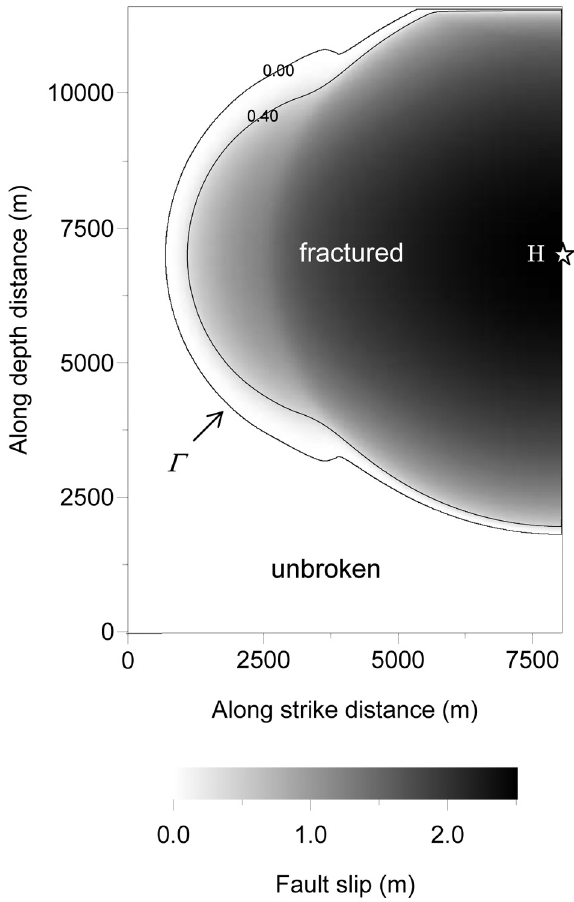
Figure 1. Distribution of the fault slip developed by a 3–D synthetic earthquake at time t = 1.92 s. The adopted parameters are listed in Table 1. Due to the symmetry with respect to the hypocenter H, we report only one half of the total fault length L f